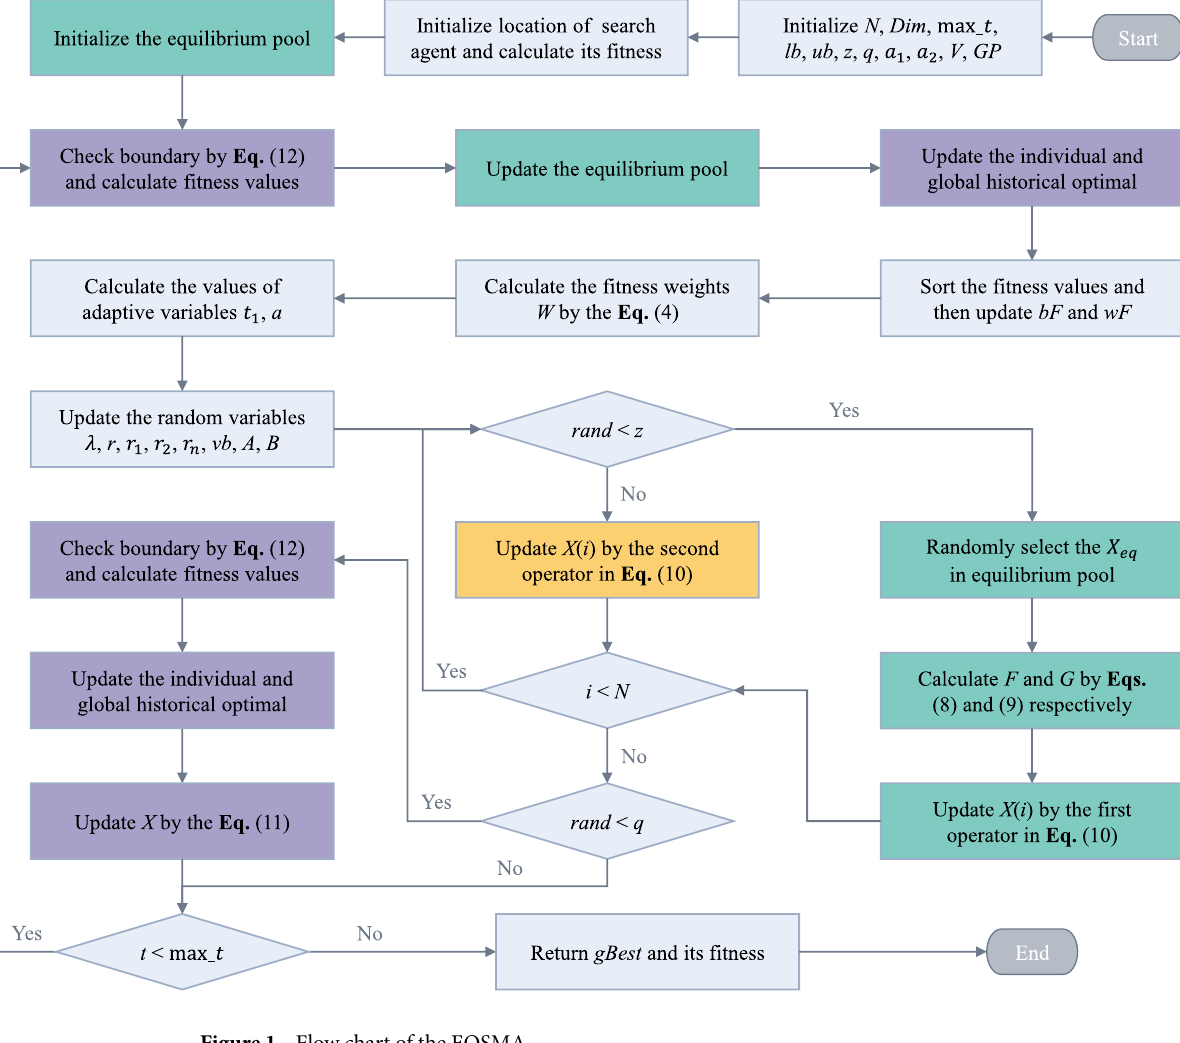
Figure 1. Flow chart of the